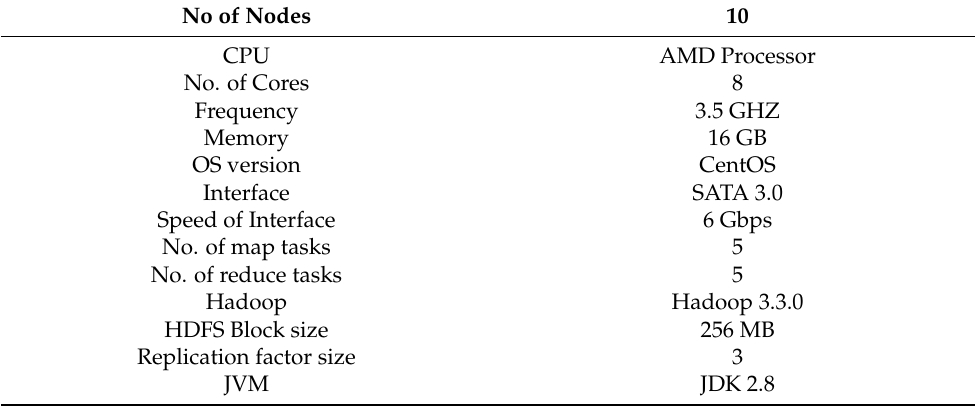
Table 1. Configuration of the Hadoop